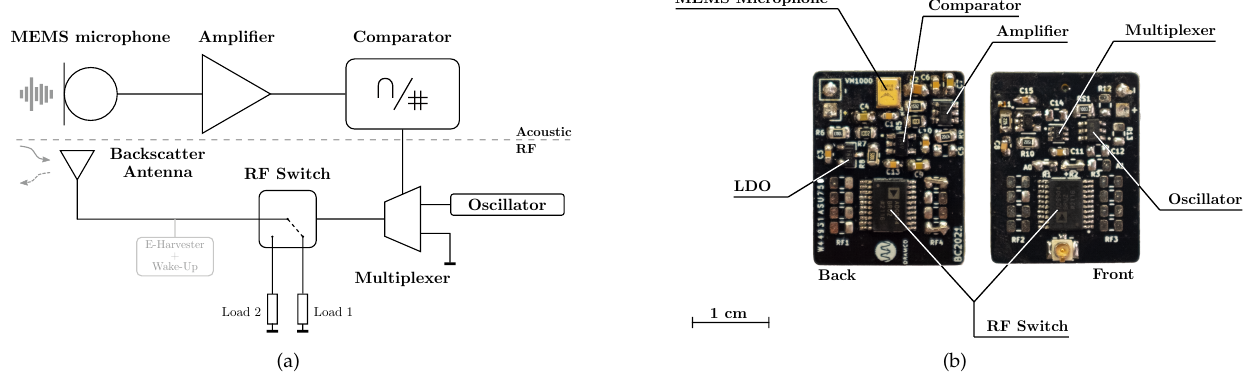
Figure 7. ( a ) Block diagram and ( b ) PCB layout of the backscatter